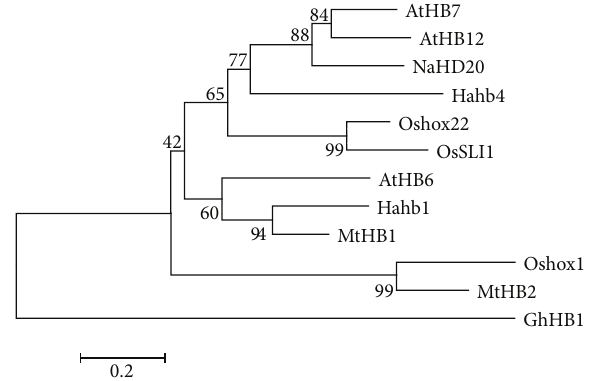
Figure 2: Phylogenetic analysis of stress-related HD-Zip proteins in plants. The neighbor-joining tree was constructed with MEGA 4.0. Branch numbers represent a percentage of the bootstrap values in 1,000 sampling replicates and the scale bar indicates branch length.